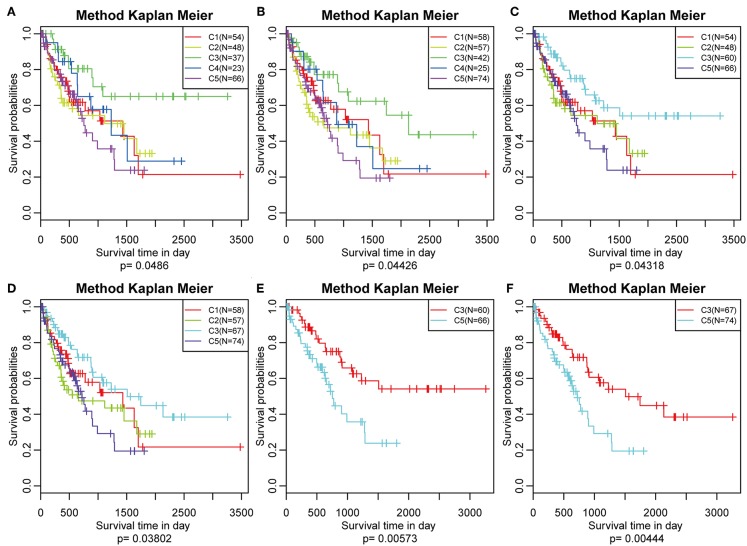
Survival analysis of the five HCC subtypes. Kaplan–Meier curves showing the distinct outcomes of HCC patients in the five molecular subtypes. The P-value was calculated using the log-rank test, by comparing the overall five subtypes together or comparing C1, C2, C3, and C5 or subtype C3 vs. subtype C5 only. (A) KM curve of disease-free survival (DFS) prognosis of five subtypes. (B) KM curve of non-progressive survival prognosis of five subtypes. (C) The prognosis difference KM curve of the non-DFS of merged C3, C4, and other subtypes. (D) The prognosis difference KM curve of the non-progression-free survival (PFS) of merged C3, C4, and others subtypes. (E) The prognosis difference KM curve of the non-DFS of merged C3, C4, and C5. (F) The prognosis difference KM curve of the non-PFS of merged C3, C4, and C5.